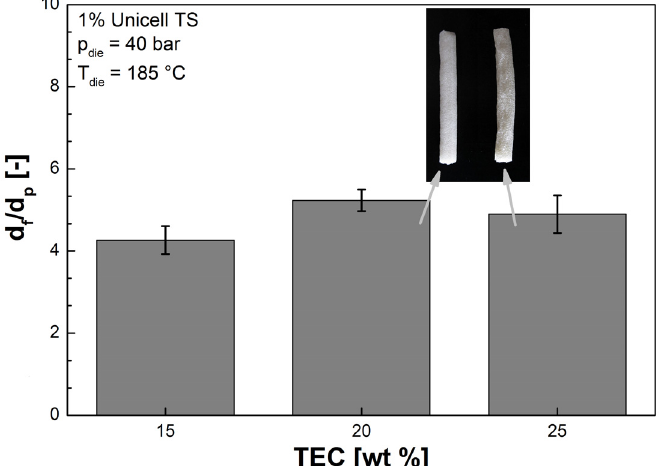
Figure 12. Expansion ratio d 40 bar as a function of TEC content.